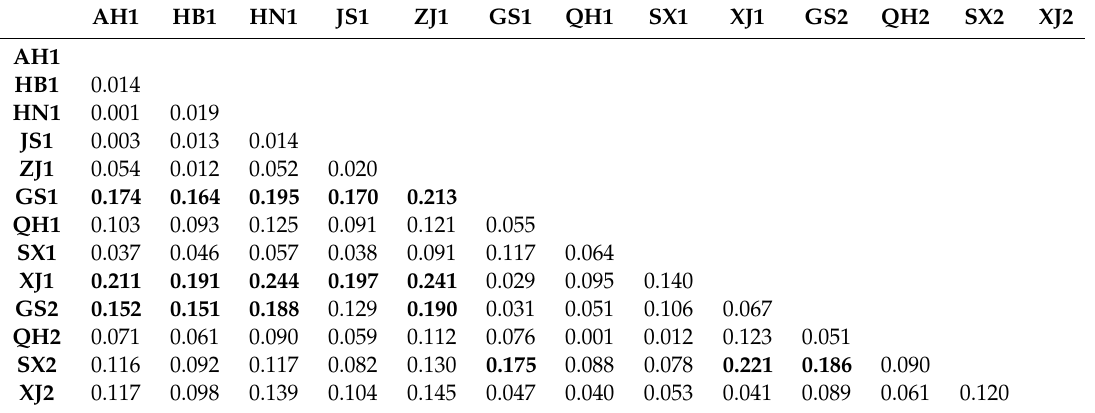
Table 3. Pairwise genetic distance estimates ( F ST ) for two Sitobion avenae biotypes from nine